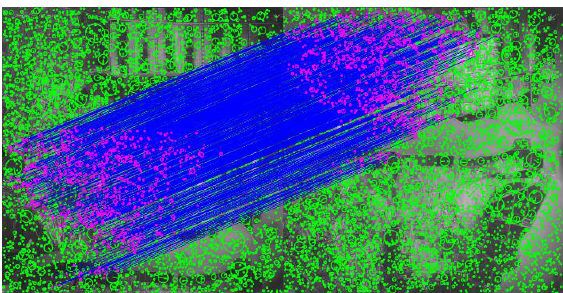
Figure 14. RANSAC result of Case